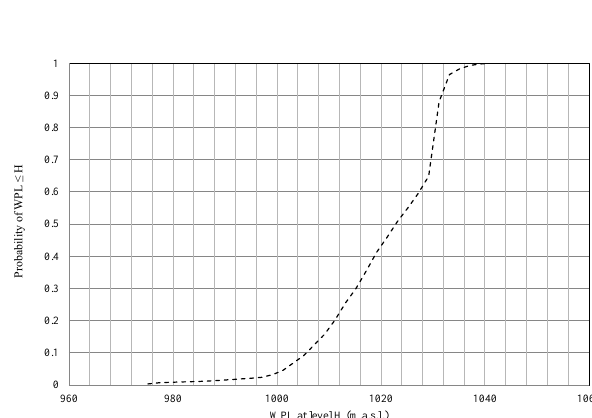
Fig. 11. Inflow rates at the reservoir for several annual exceedance probabilities (PAE). Fig. 12. Exceedance probabilities of water pool levels (WPL) at the